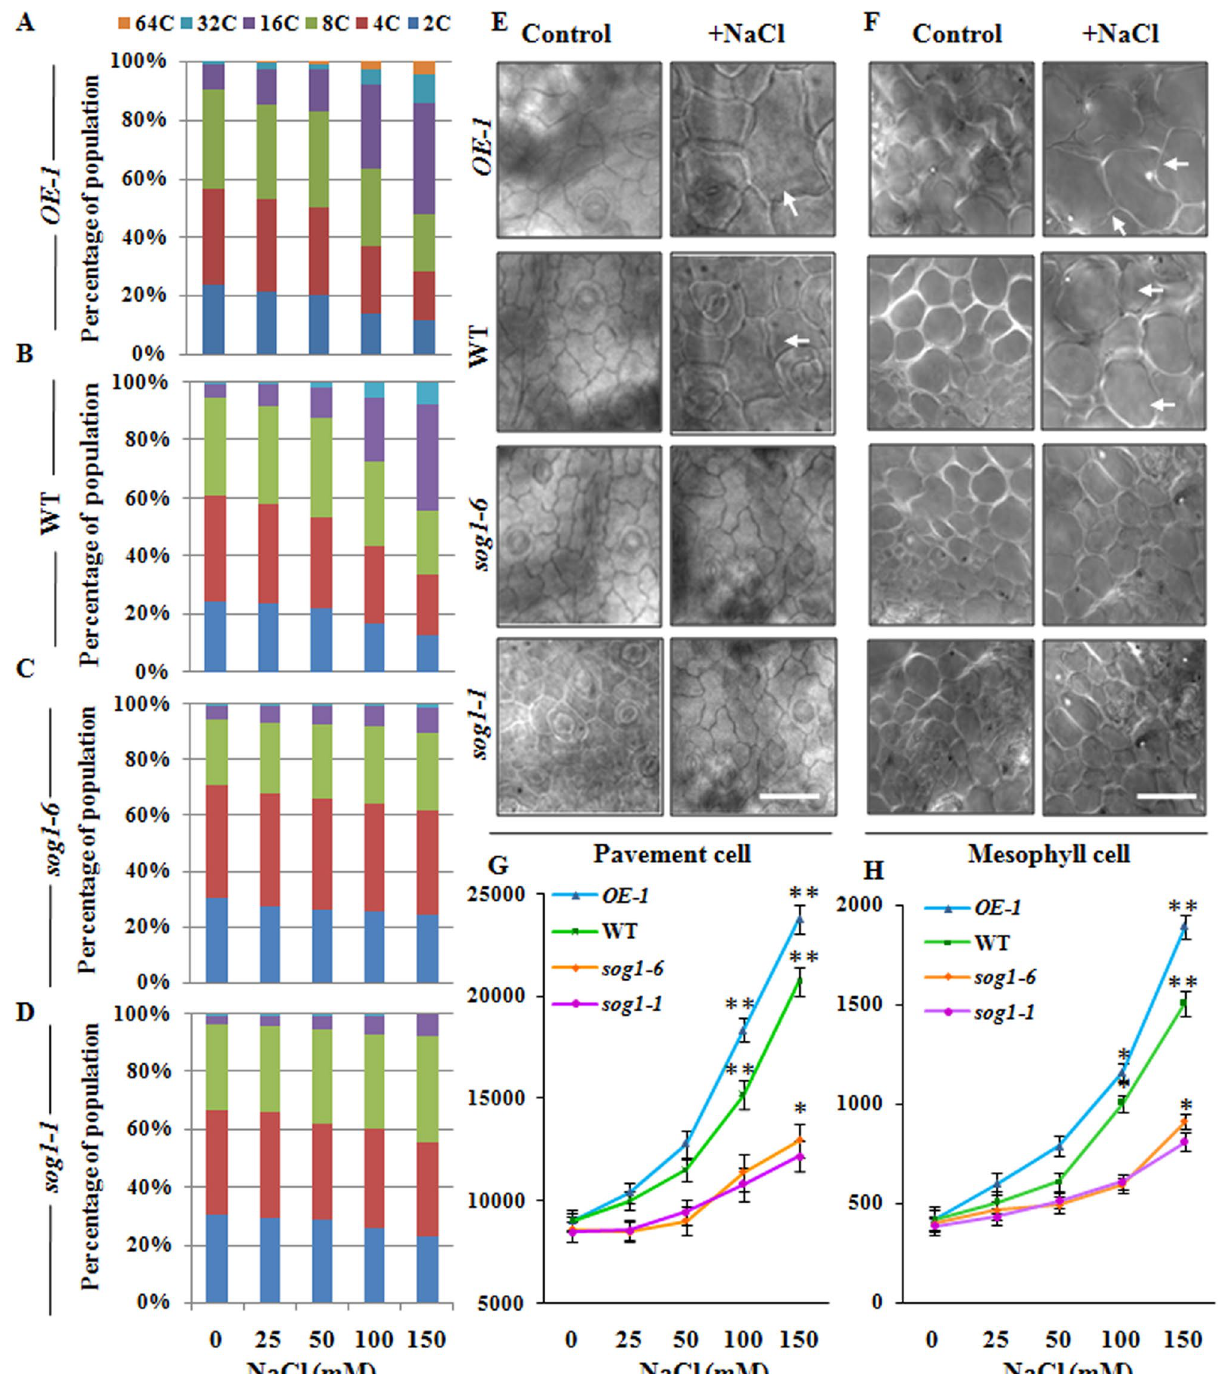
Figure 7. Induction of endopolyploidy in leaf epidermal and mesophyll cells. ( A – D ) Flowcytometric analysis of ploidy level in the nuclei isolated from the first and second pair of leaves of SOG1 overexpressor line OE-1, wild-type, sog1-6 and sog1-1 mutant plants exposed to increasing concentrations of NaCl. ( E , F ) Change in cell surface area of epidermal pavement cells (Scale bar: 100 μm) and mesophyll cells (Scale bar: 50 μm) of SOG1 overexpressor line OE-1 , wild- type, sog1-6 and sog1-1 mutant plants, either in absence or presence of NaCl. Leaf epidermal pavement cells and mesophyll cells in the basal region of primary leaves were photographed. White arrows indicating enlarged pavement and mesophyll cells. ( G , H ) Measurement of cell surface area of leaf pavement and mesophyll cells in leaves of all the four genotypes exposed to increasing concentrations of NaCl. Leaf surface areas were measured using ImageJ software (NIH). Data of the leaf surface area presented are the mean value of three independent biological replicates. Error bar represents ± SD (n = 40). Asterisks indicate a significant difference between untreated control and treated samples for each genotype based on one-way ANOVA factorial analysis (* p < 0.05, ** p <